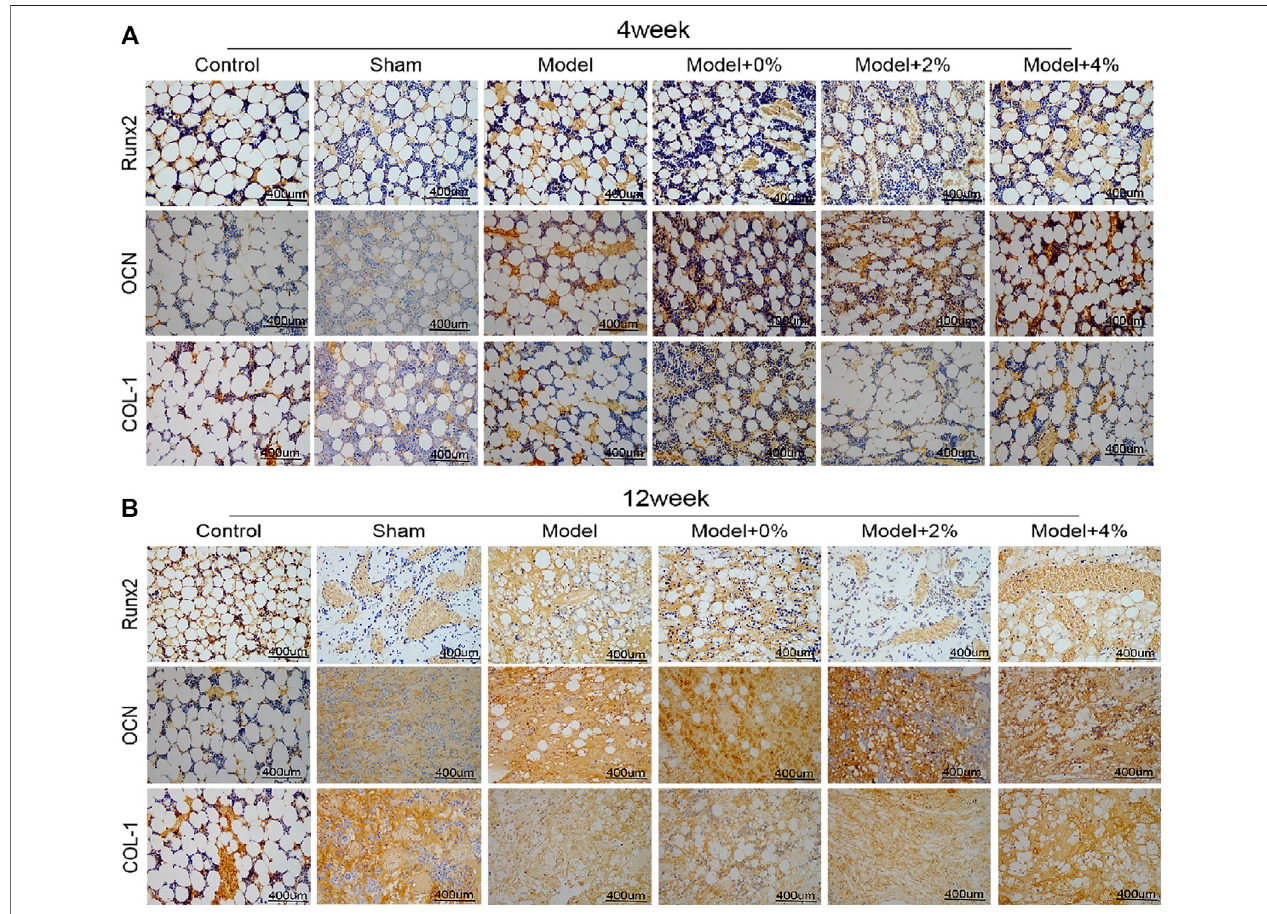
FIGURE 5 | The immumohistochemical staining for detecting the expression of Runx2, OCN and COL-1 at 4 (A) and 12 (B) weeks (400 ×).